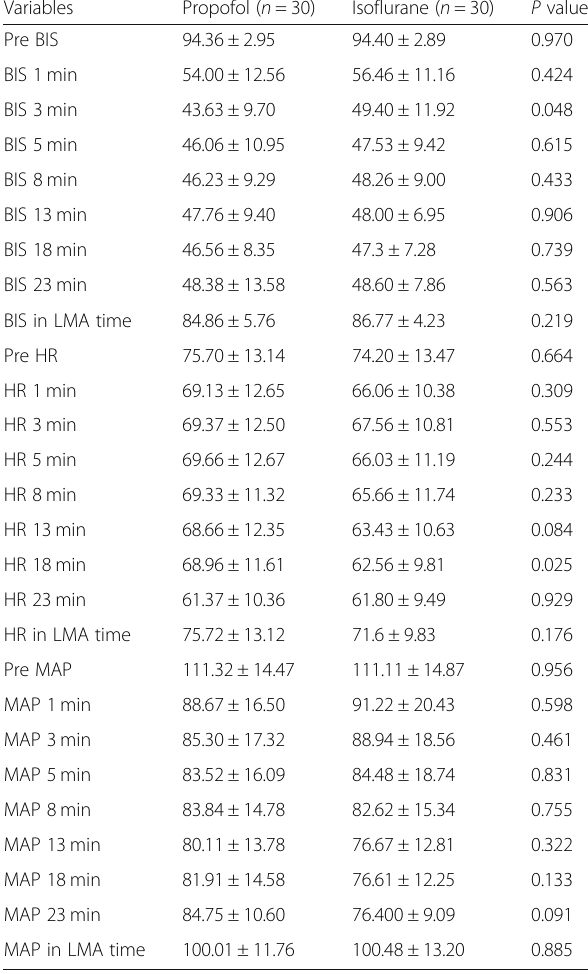
Table 2 Average trend of BIS, heart rate, and MAP during cataract surgery between two intervention groups